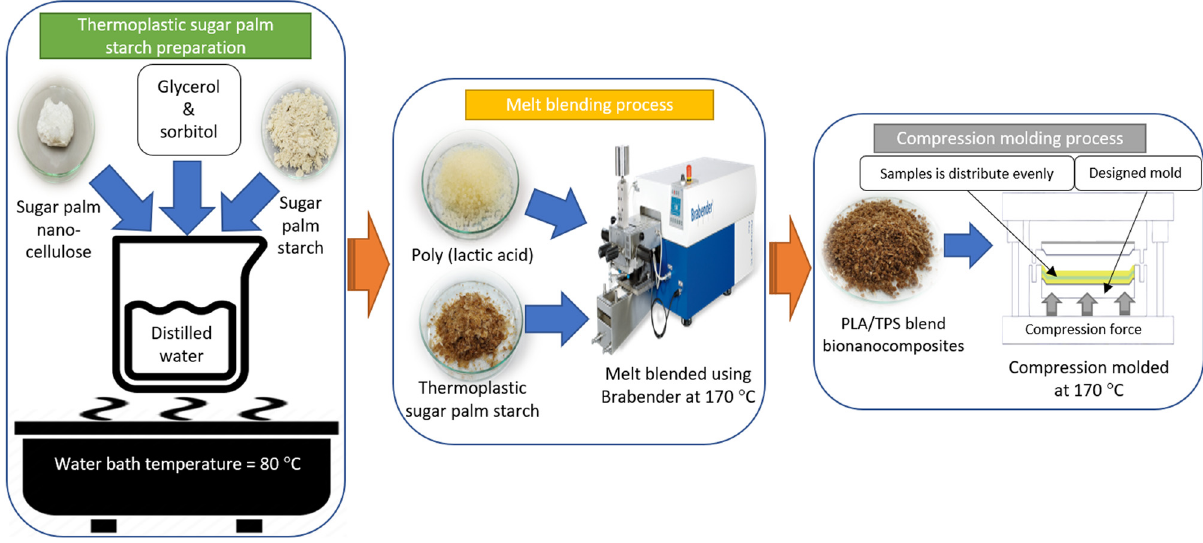
Figure 1: Schematic diagram of the preparation of PLA/TPS blend